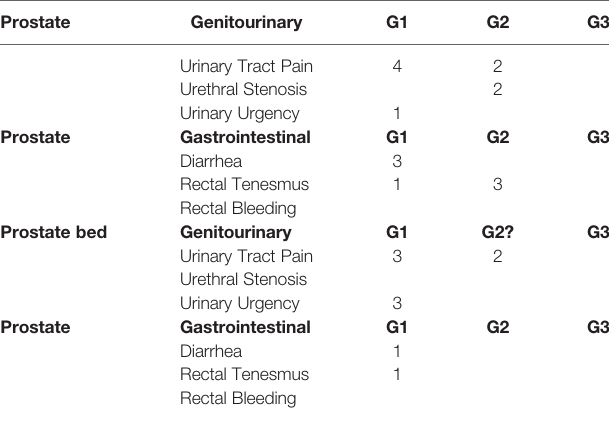
TABLE 4 | Late toxicity patterns for prostate and prostate bed re-irradiation.